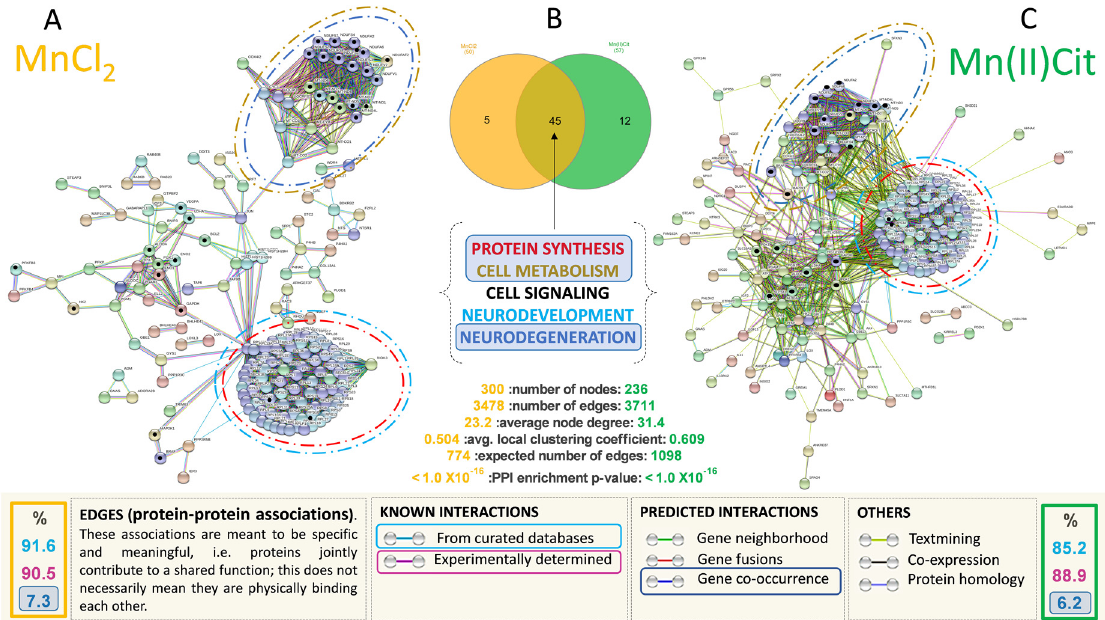
Figure 3. ( A , C ) represent an inferred enriched protein–protein interactions (PPI) network for cells stressed with MnCl 2 and Mn(II)Cit, respectively; p -value < 1.0 × 10 − 16 . More than 85% of these interactions are derived experimentally. The predicted PPIs were calculated with high confidence score (0.9) and proteins/genes with no connections were removed. ( B ) Overlapping representation of 45 pathways that were affected by MnCl 2 and Mn(II)Cit. These interactions can be categorized in Protein Synthesis, Cell Metabolism, Cell Signaling, Neurodevelopment, and Neurodegeneration